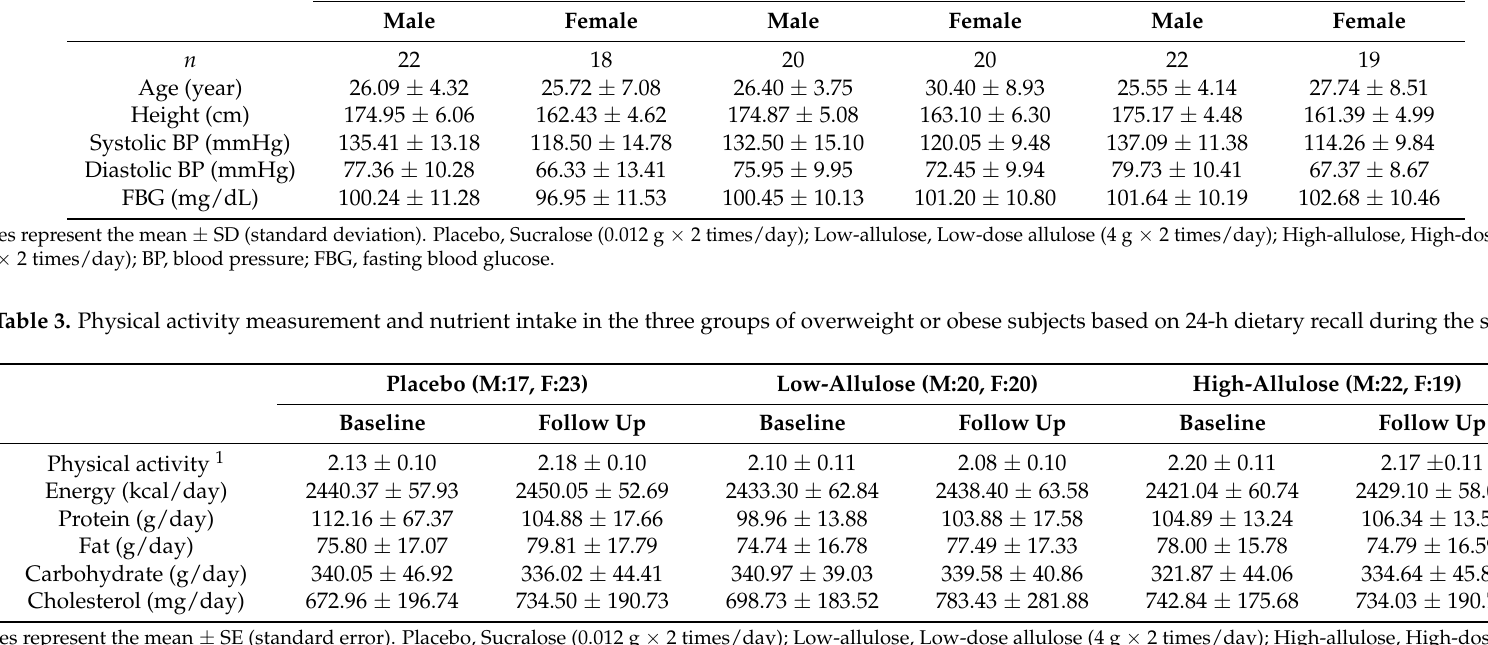
Table 2. Baseline characteristics of the three groups of overweight or obese subjects who participated in a dose-dependent efficacy test of D -allulose. Placebo Low-Allulose High-Allulose Male Female Male Female Male Female n 22